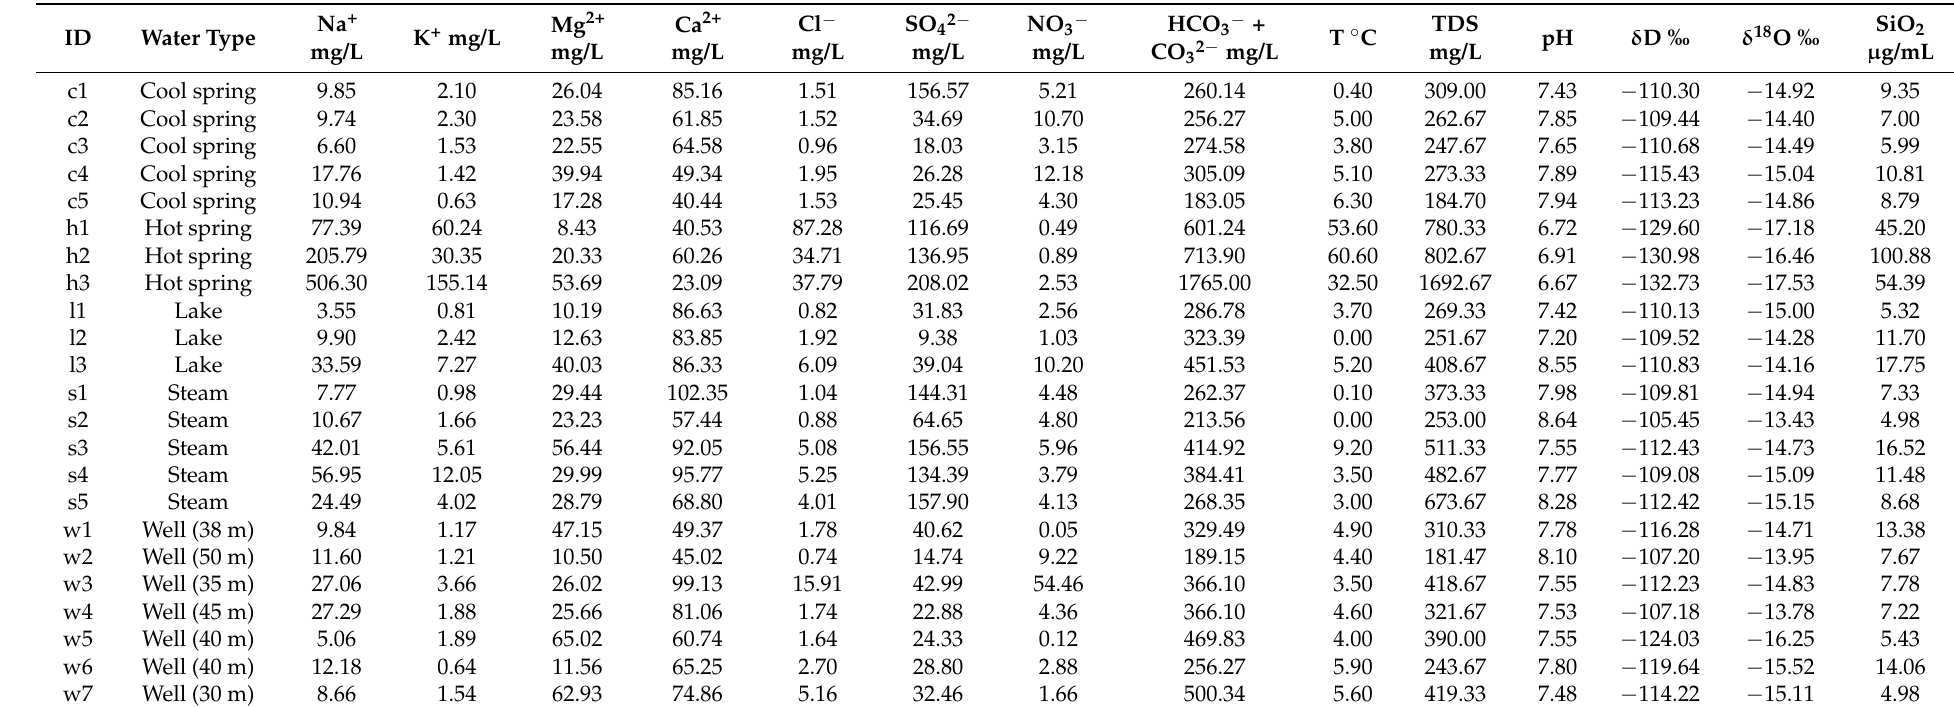
Table 1. Hydrochemical data from the study